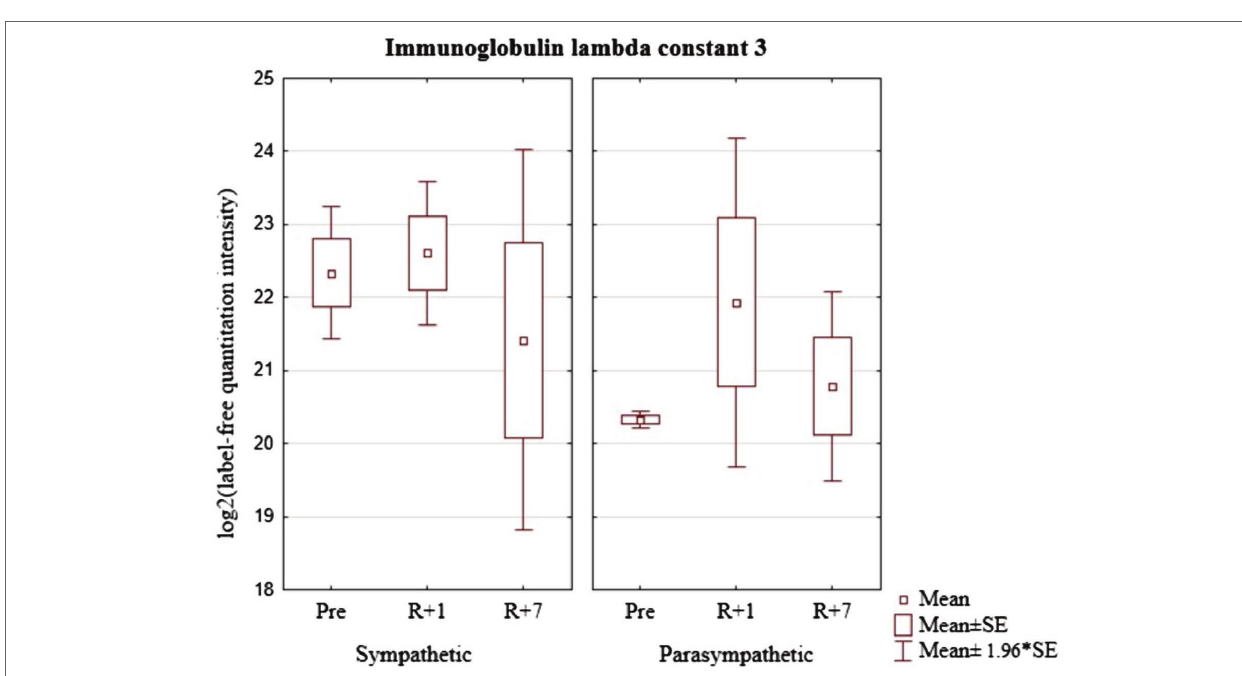
FIGURE 8 | Immunoglobulin lambda constant 3 (Gene IGLC3) levels in cosmonaut groups pre-mission (Pre), on the 1st day (R + 1) and on the 7th day (R + 7) after